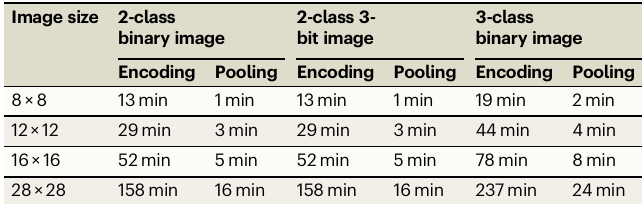
Table 5 | The run-time in minutes for a single input of the three experiments: 2-class classi fi cation for binary images, 3-class classi fi cation for binary images, and 2-class classi fi cation